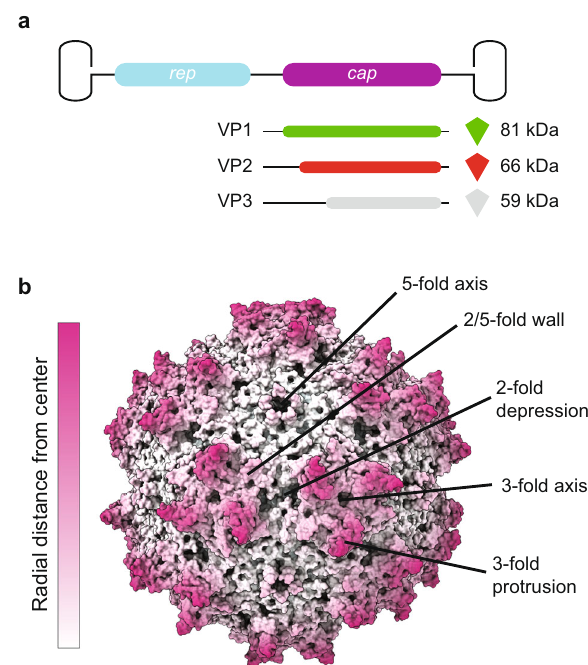
Fig. 1 Adeno-associated virus (AAV) capsid structure. a The capsid is composed of 60 copies of a combination of VP1, VP2, and VP3. For the VPs we use the green, red, and gray color scheme, respectively, throughout the manuscript. The three VPs are encoded within the same cap ORF where the different VPs are produced via differential splicing and alternate start codons. All VPs share a common C-terminal VP3 sequence. b An AAV1 structure (PDB ID: 3NG9) radially colored from the capsid center (white to purple). The approximate icosahedral 2-, 3-, 5-fold axes along with the 2/5-fold wall are labeled. The icosahedral symmetry is retained by VP3, whereas the VP1 and VP2 extensions, and the variable stoichiometry result in a breakdown of this